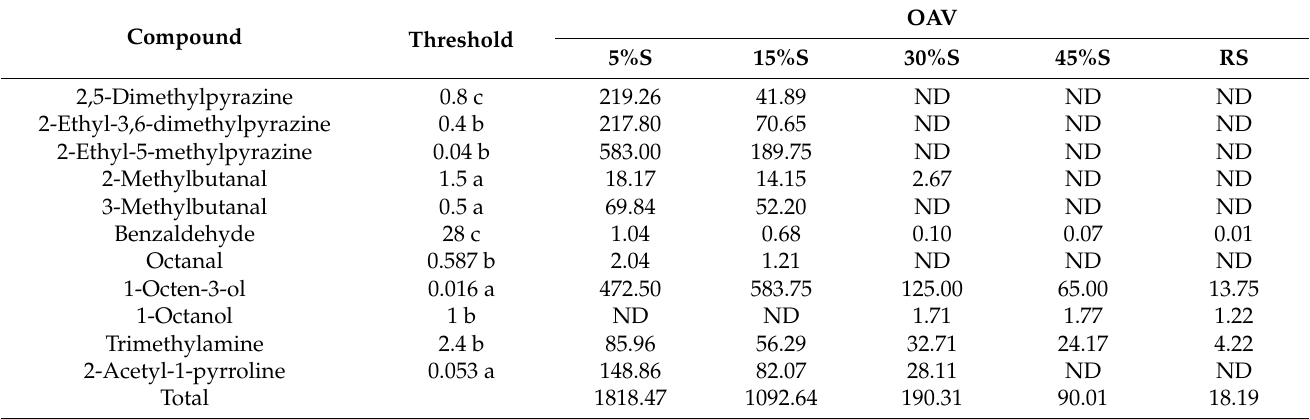
Table 1. Odor thresholds and aroma-active compounds in